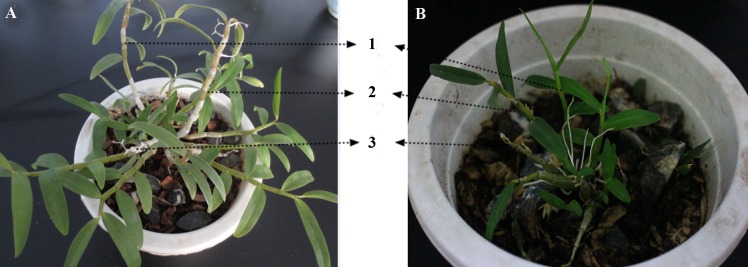
Cultivated Dendrobium seedlings.(A) Cultivated D. officinale (B) Cultivated D. huoshanense; 1, 2, and 3 represent one-,two- and three-year-old seedlings.